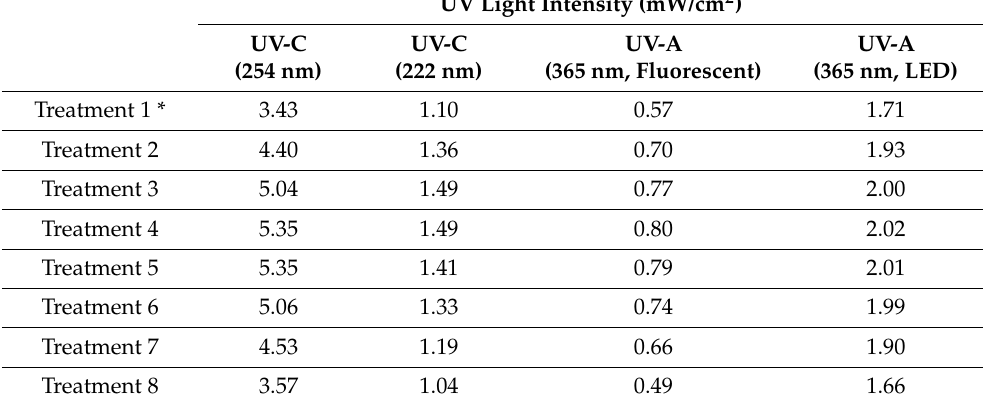
Table 1. Average UV light intensity for each treatment (quartz tube #) was measured without tube shielding. In the experiment, the quartz tubes were covered with different lengths of polyvinyl chloride (PVC) pipes to control the UV dose, and thus, the effective light intensity was estimated for each treatment